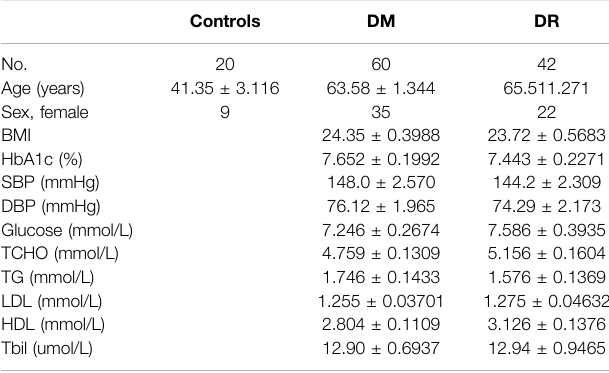
TABLE 3 | Detailed clinical parameters of study population. Controls